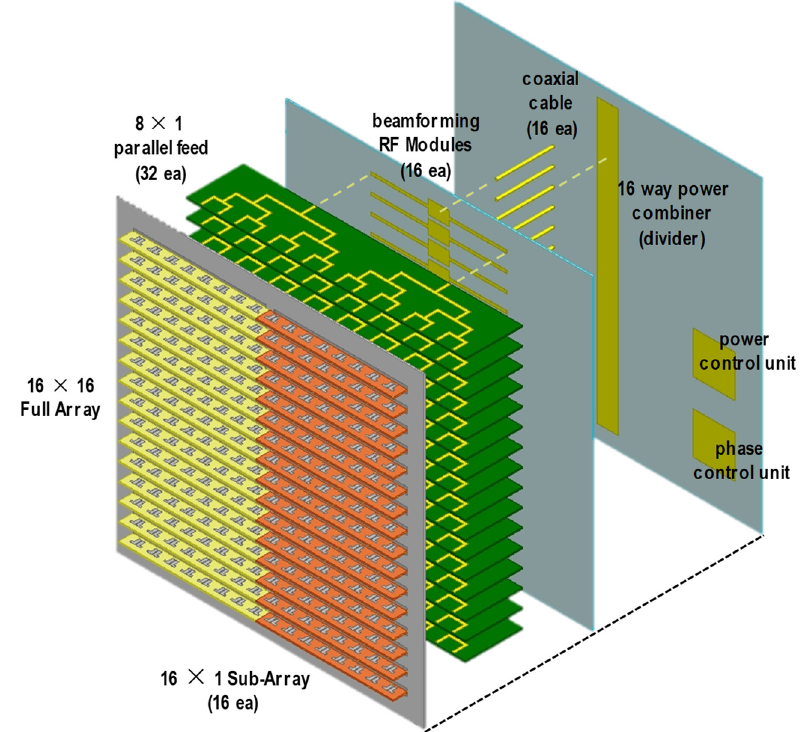
Figure 1. Configuration of the proposed S-band-receiving phased-array antenna.